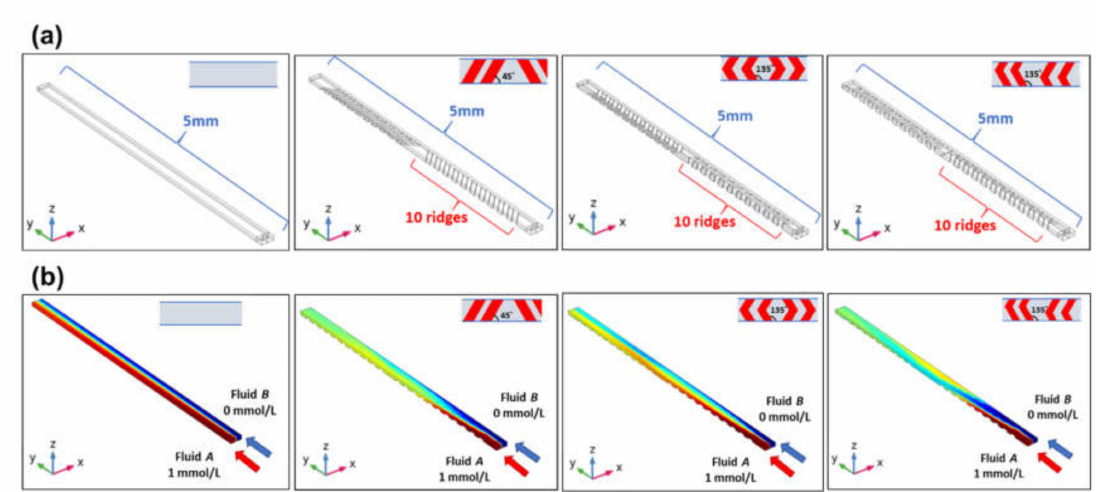
Figure 10. ( a ) Three-dimensional FEM models showing a rectangular microchannel without any ridge structures, and with periodic oblique ridges, symmetric V-shaped ridges, and asymmetric V-shaped ridges. ( b ) Simulation results showing the concentration contours of two di ff erent fluids (with a concentration of 0 and 1 mmol / L) in each microchannel at a flow velocity of 0.0128 m / s each (equivalent to 5 µ L /